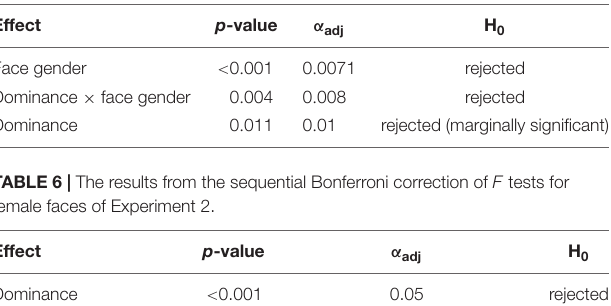
TABLE 5 | The results from the sequential Bonferroni correction of seven different F tests of Experiment 2.